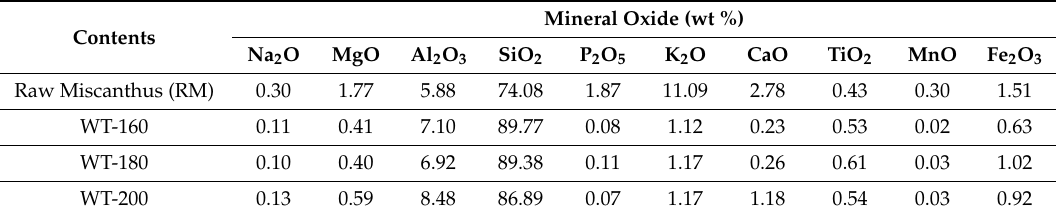
Table 3. Mineral oxide contents of raw miscanthus (RM) and wet torrefaction (WT) samples.